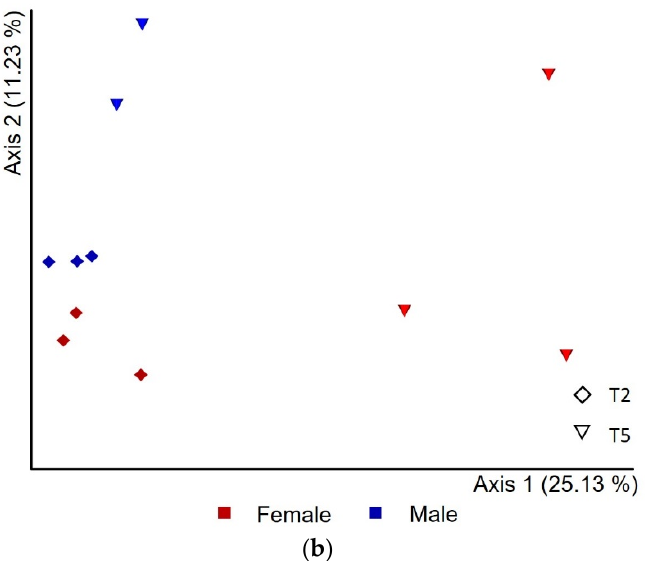
Figure 3. Principal coordinate analysis (PCoA) plot based on the ( a ) weighted UniFrac metric for bacterial communities. Permutational multivariate analysis of variance indicated that the bacterial community of males and females did not vary significantly (PERMANOVA’s pseudo-F = 1.80, p = 0.12), while the bacterial community of mycangia from different cork oaks was significantly different (PERMANOVA’s pseudo-F = 2.42, p = 0.01); ( b ) Bray–Curtis distance showed cluster separation between sexes in selected trees T2 and T5, without significant variation (PERMANOVA’s pseudo-F = 1.29, p = 0.17).